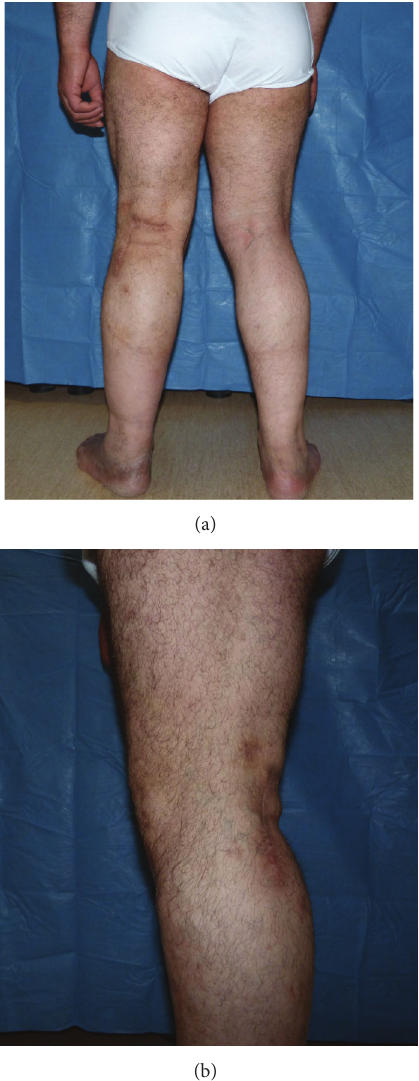
Figure 7: Lateral and posterior view of the patient one year after the